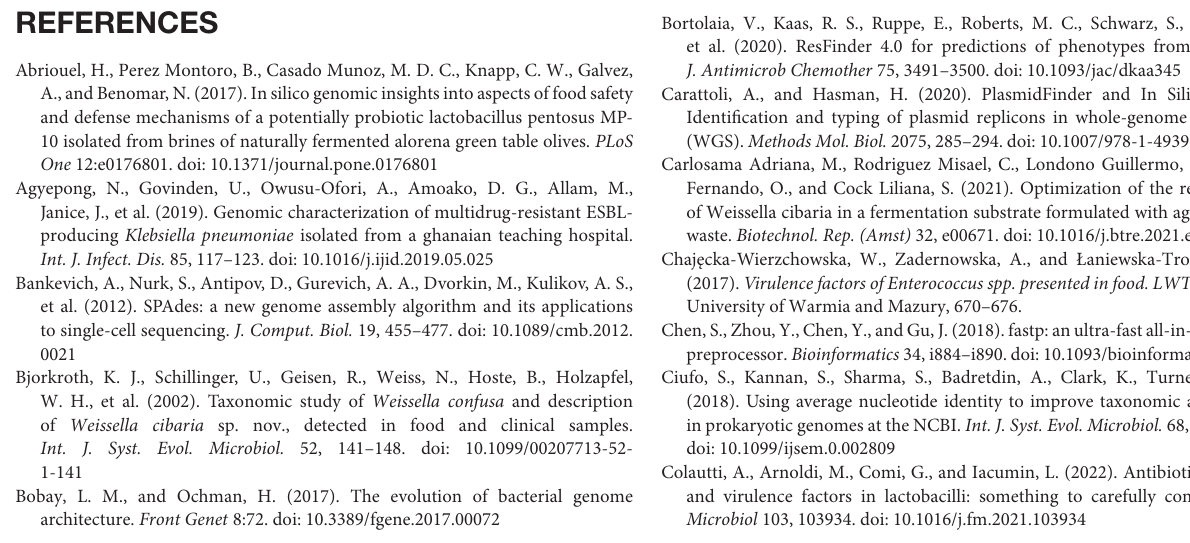
Supplementary Table 1 | List of bacterial strains used in this study. Supplementary Table 2 | AAI Analysis of 219 Weissella strains. Supplementary Table 3 | CRISPR identification in Weissella